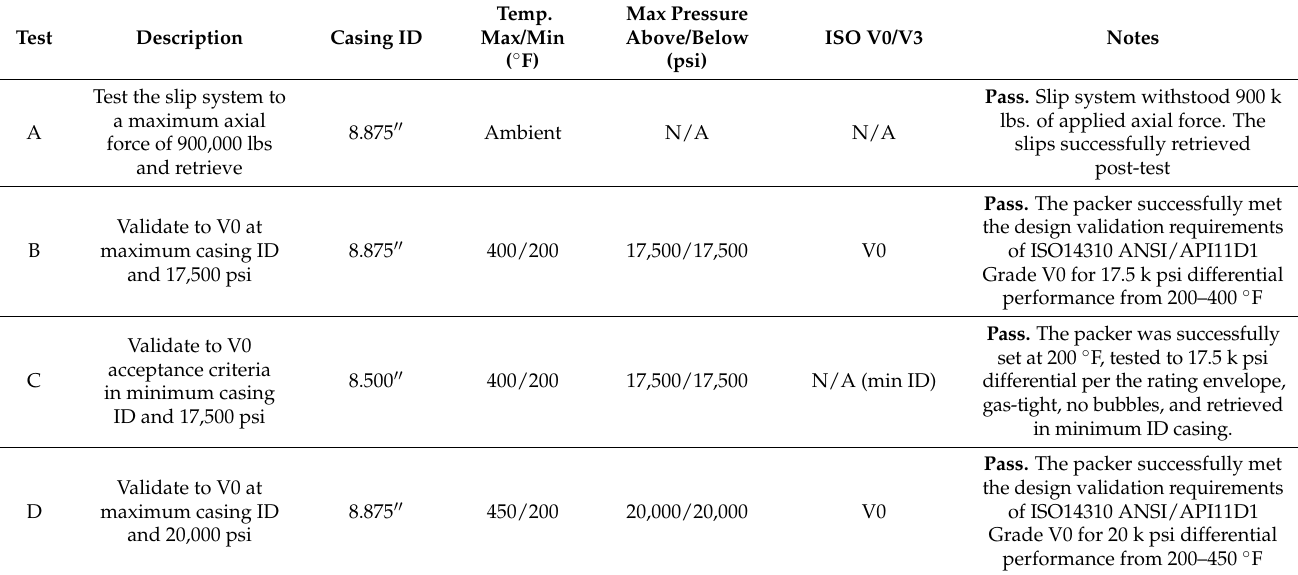
Table 6. Test results of the ultra-HPHT retrievable packers